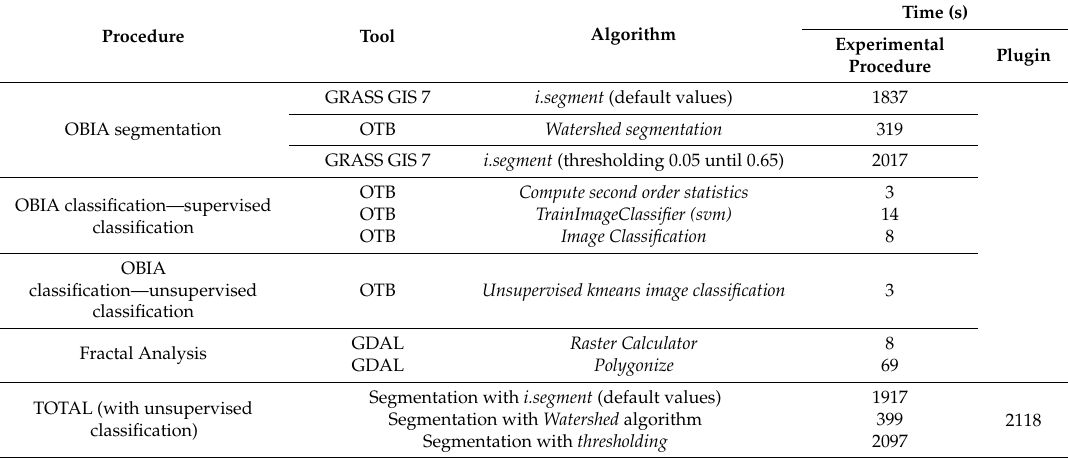
Table 2. Processing time of manually procedure and